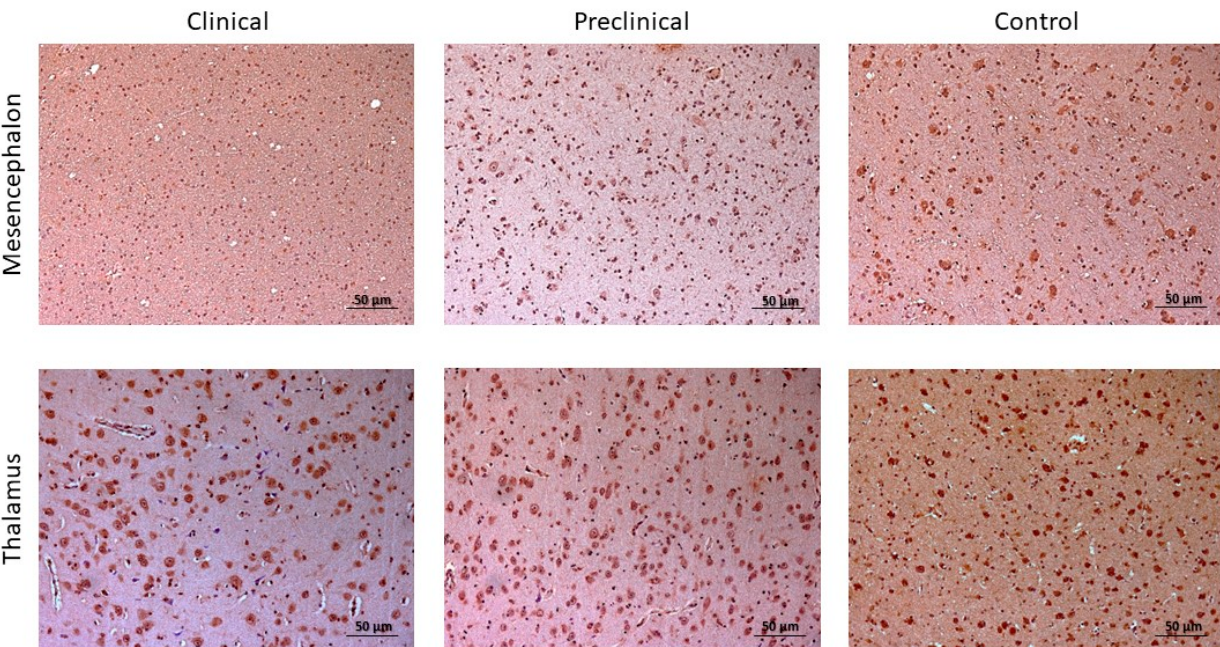
Figure 9. Immunostaining determination of 5mC in mesencephalon and thalamus of preclinical, clinical, and control sheep.